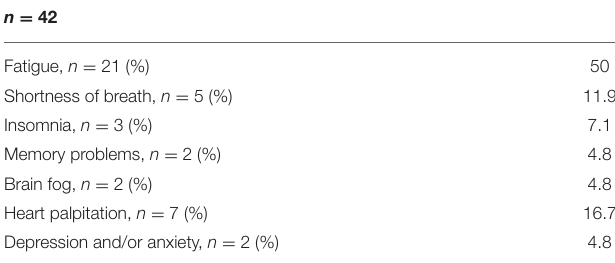
TABLE 2 | Post-COVID